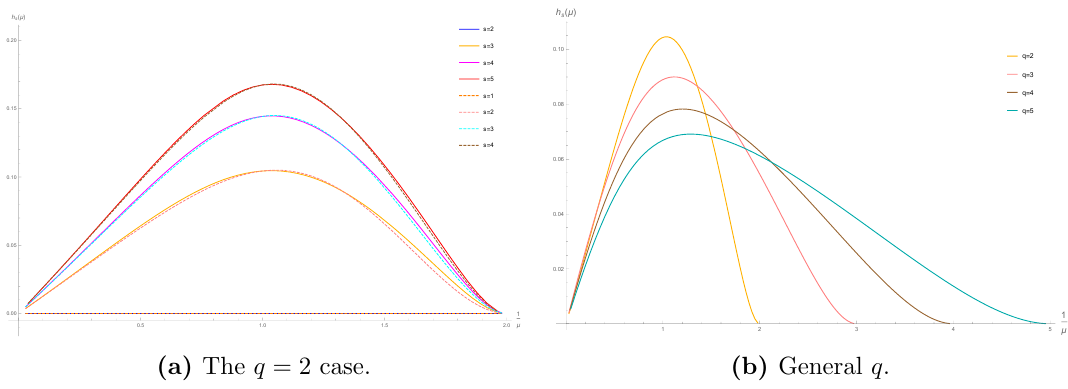
(a) The q = 2 case. (b) General q . Figure 10. Anomalous dimension of the anti-holomrphic higher-spin operators. The solid curves are for operators in the symmetric channel and the dashed lines are for operators in the antisym- metric channel. The plot is for q = 3. No overlapping of the solid and dashed curves are obvserved, which re(cid:13)ects the absence of supersymmetry in the left-moving sector. between the symmetric and antisymmetric channels. This indicates that in the infrared the model only has N = (0 ; 2) supersymmetry, namely there is no supersymmetry in the left-moving section, away from the higher-spin limits (4.1) and